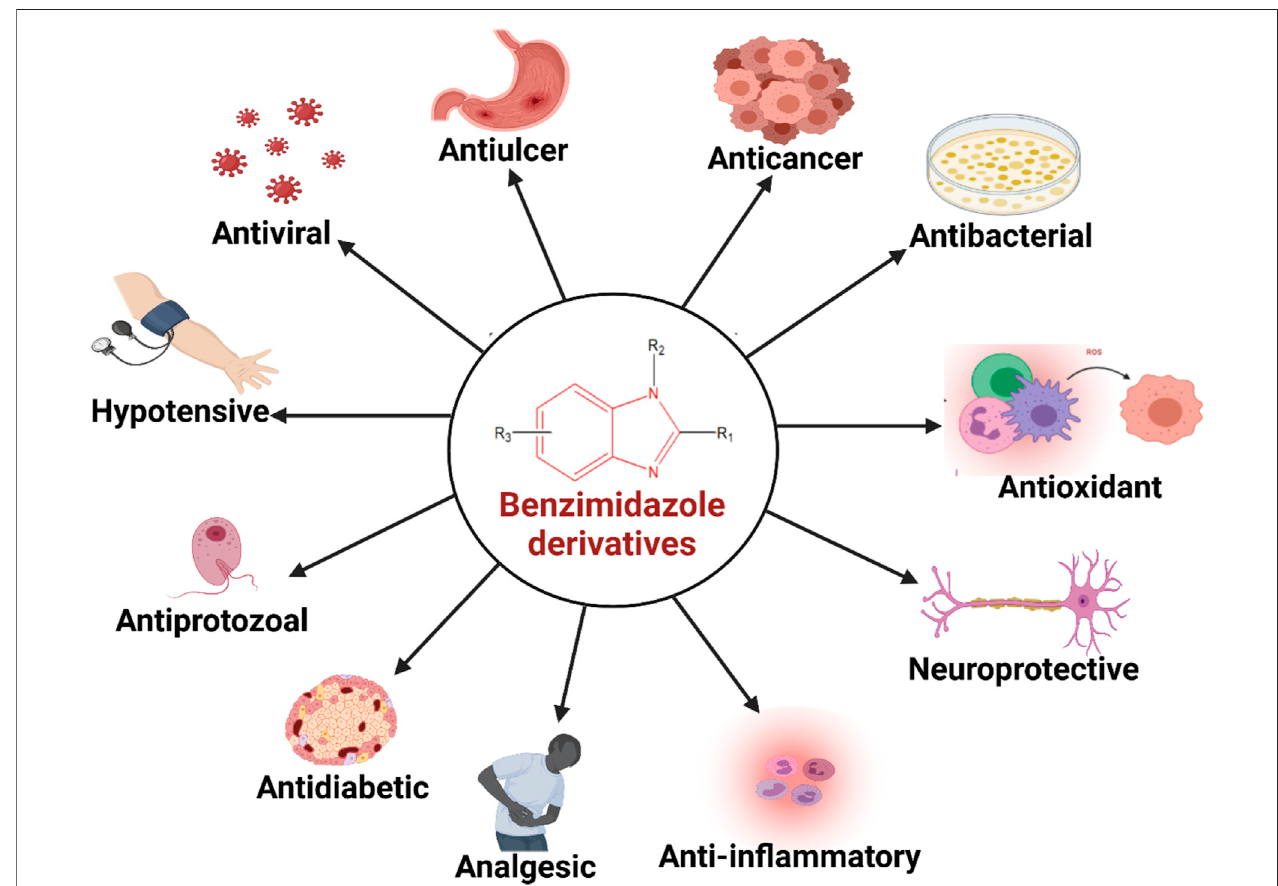
FIGURE 1 | Diverse biological activities of benzimidazole